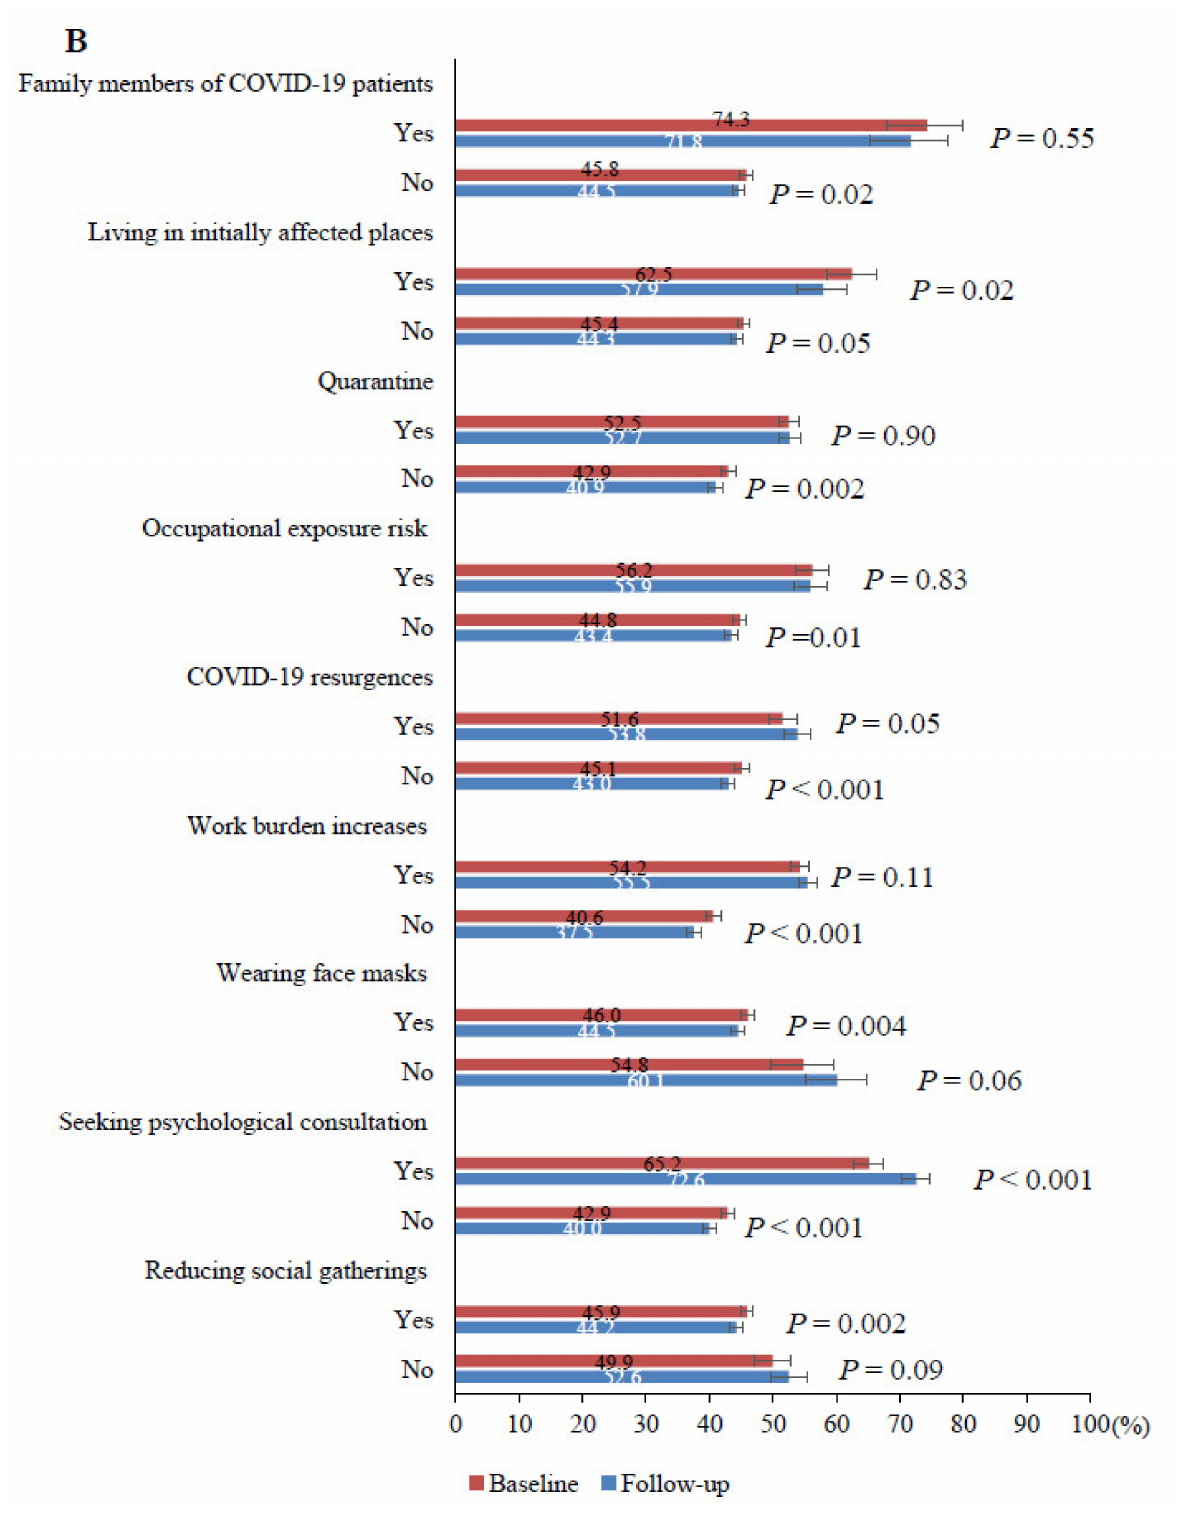
Figure 2. Changes in weighted prevalence of any mental health symptoms from baseline to follow-up survey. ( A ). Prevalence stratified by demographic-related factors. ( B ). Prevalence stratified by personal- and work-related epidemic factors. Any mental health symptoms is defined as having either depression, anxiety or insomnia. p -Values are from McNemar tests for statistically significant differences in prevalence of any mental health symptom in baseline vs. follow-up survey. The error bars indicate